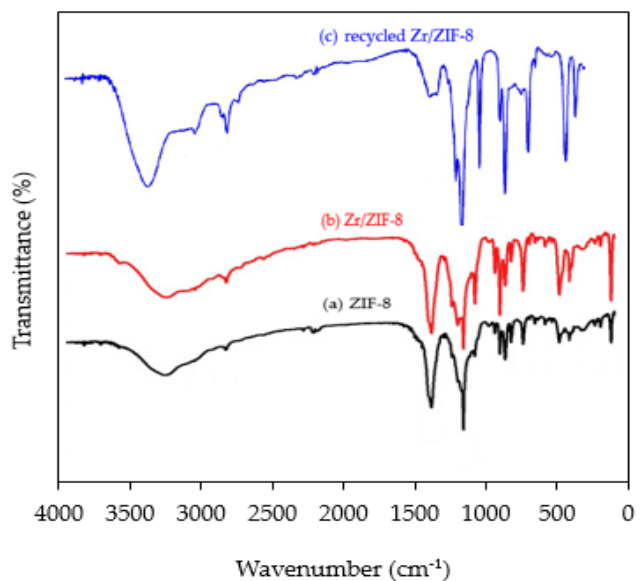
Figure 8. Fourier-transform infrared spectroscopy (FTIR) spectra of ( a ) ZIF-8, ( b ) Zr / ZIF-8, and ( c ) recycled Zr / ZIF-8 particles.